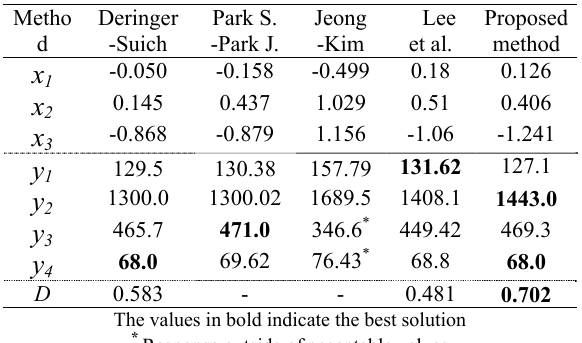
Table 16. Comparison of results for example 1: Methods from literature and approach proposed Metho